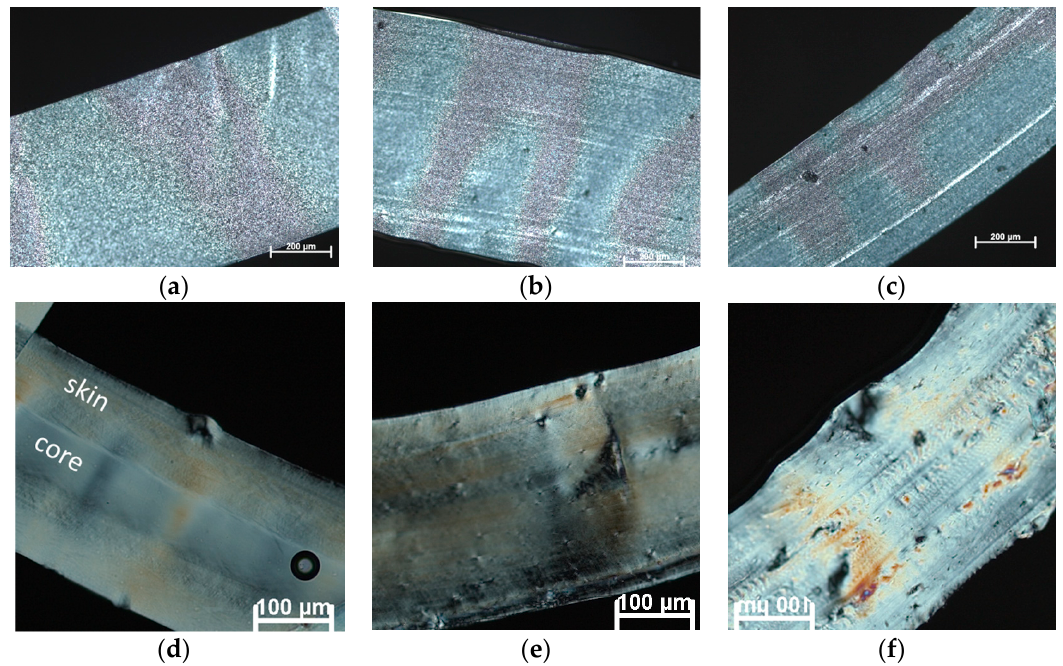
Figure 3. Polarized optical microscopy (POM) images of as-extruded films. Top row shows samples cooled with open chill rolls: ( a ) sample 1.1: PCL, ( b ) sample 3.1: PCL + 2 wt% sep; ( c ) sample 5.1: PCL + 4 wt% sep. Bottom row shows samples cooled with closed chill rolls: ( d ) sample 2.1: PCL, ( e ) sample 4.1: PCL + 2 wt% sep, ( f ) sample 6.1: PCL + 4 wt% sep. The white arrows indicate